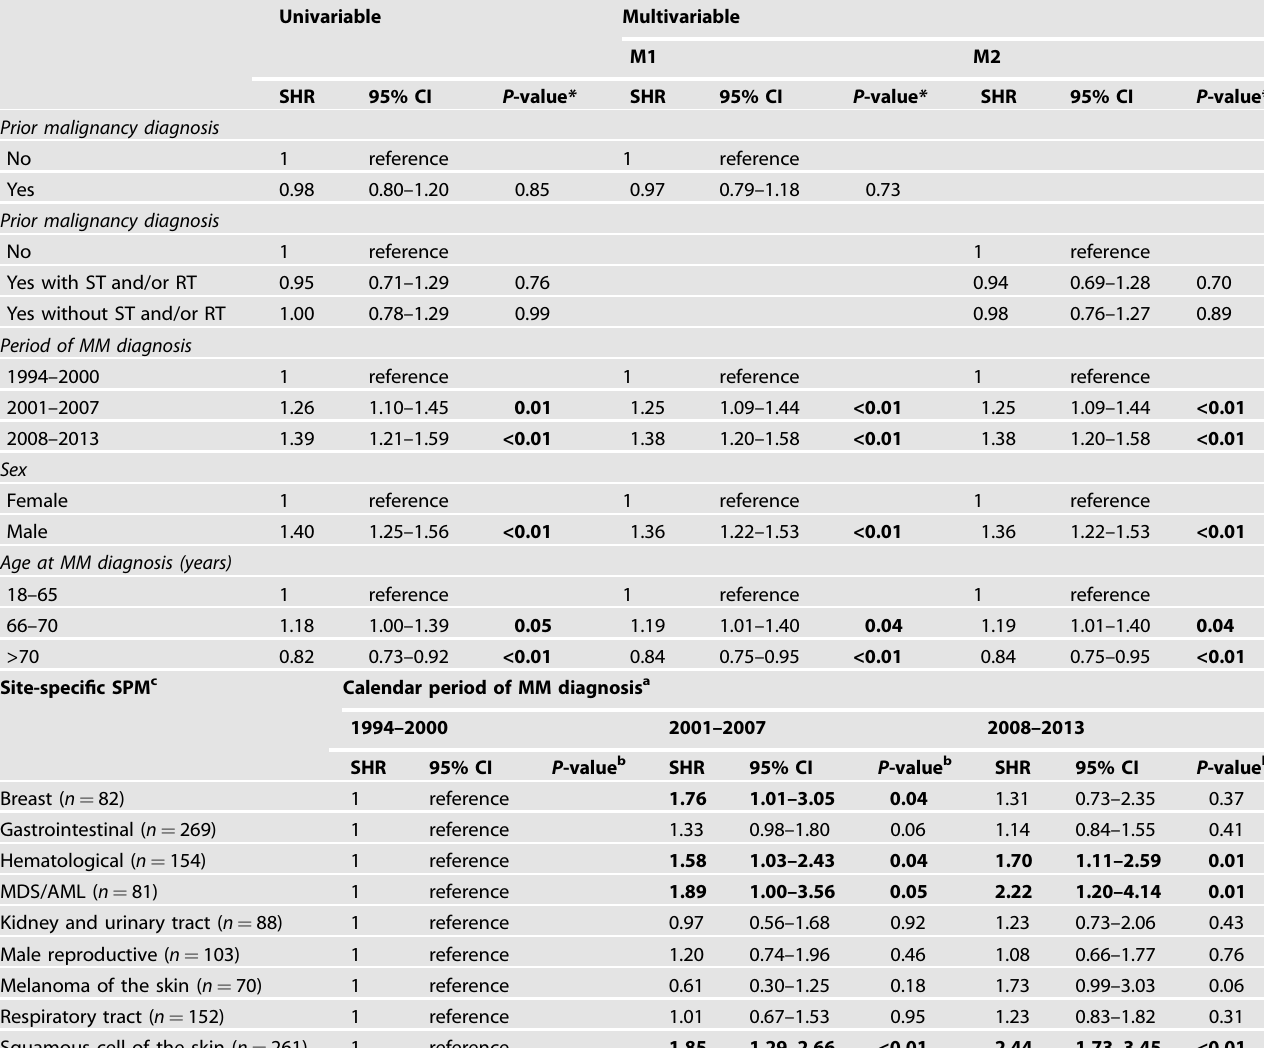
Table 1. Competing risk regression models for the association between a history of malignancies and the development of subsequent primary malignancies after multiple myeloma patients in the Netherlands (panel A ) and for risk of developing a certain site-speci fi c subsequent malignancy among MM patients according to calendar period, using competing risk regression (panel B